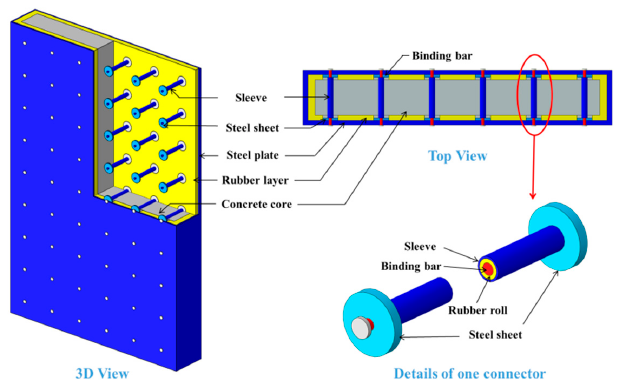
Figure 2. Configuration of the steel-damping-concrete (SDC) wall.